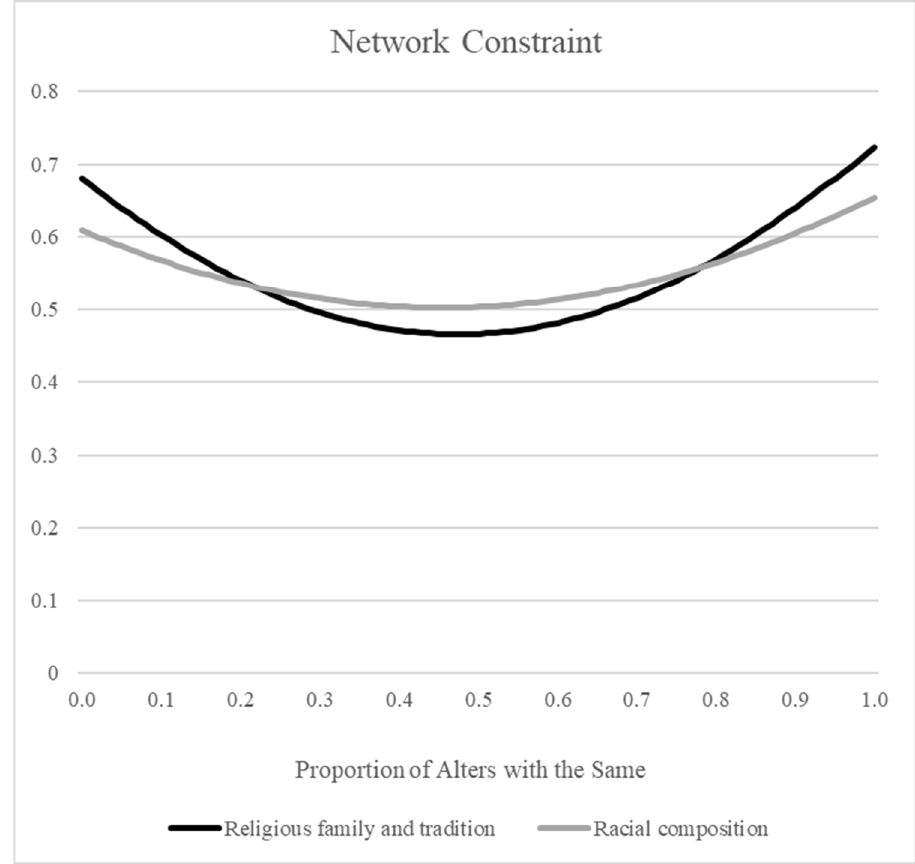
Figure 3. Predicted network constraint by homophily.